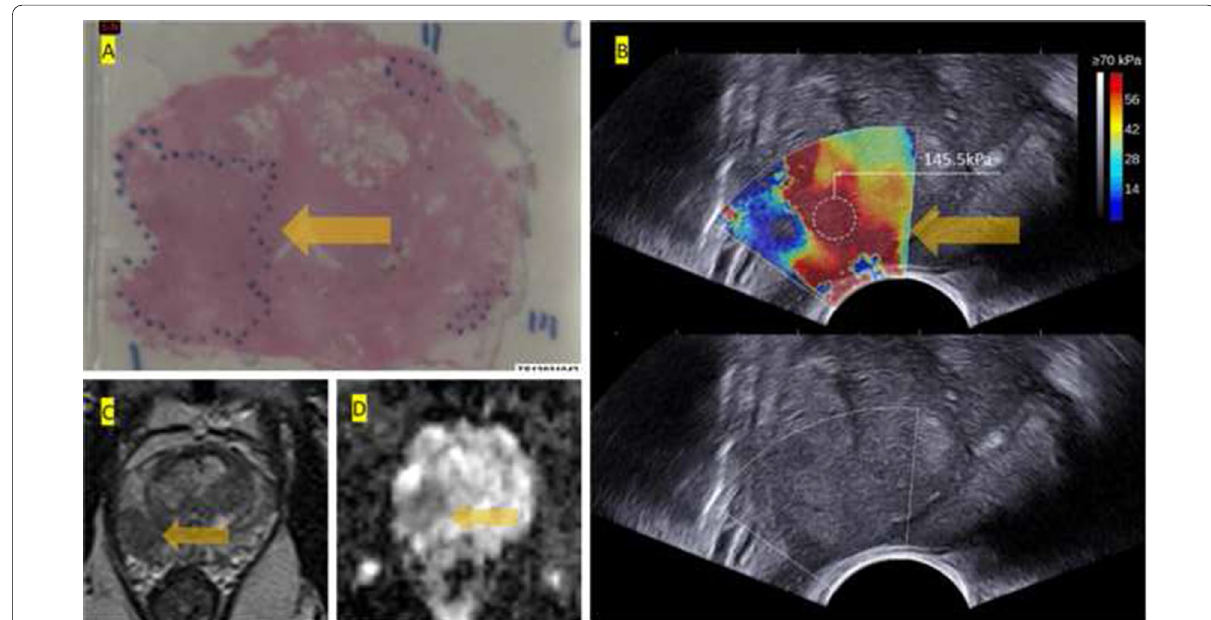
Fig. 2 a Histopathology of whole‑mount prostate with Gleason score 4 5 cancer in dotted area. b Ultrasound shear wave elastography USWE + with pseudo‑colour map; note cursor in red area with bar showing a quantitative stiffness measurement of 145.5 kPa (very high grade). B‑Mode ultrasound showing no clue of suspected cancer. c , d T2w and ADC map images of the lesion from 3 T mpMRI scored as PI‑RADS